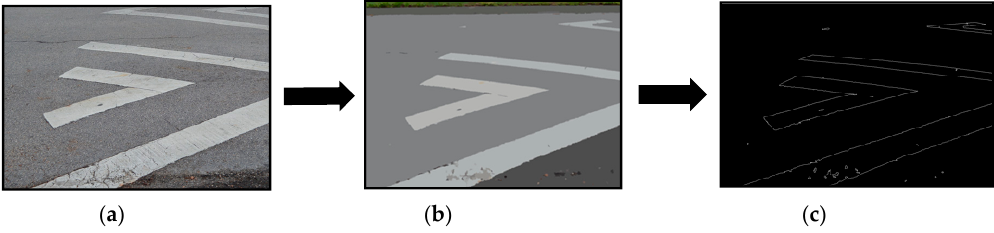
Figure 4. Extraction of road markings from images—( a ) Localization of road marking; ( b ) Segmented image; (c) Edges extracted from segmented image showing boundaries of road markings.